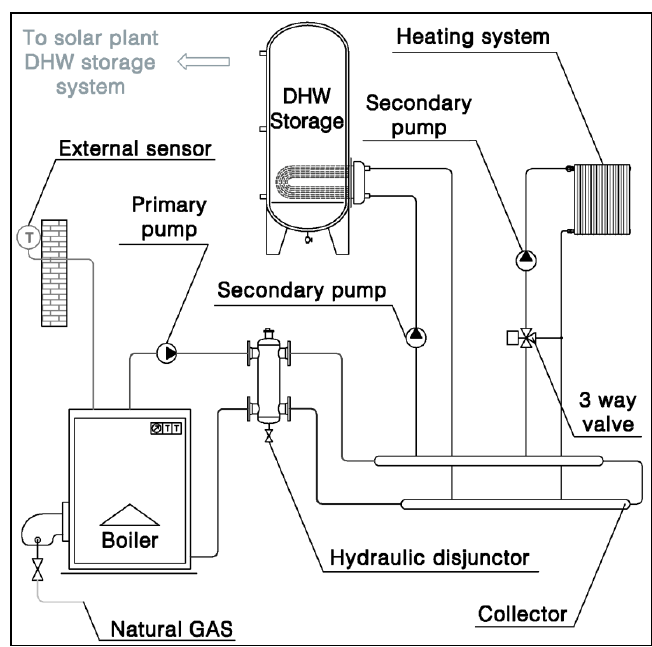
Figure 2. Centralized heating